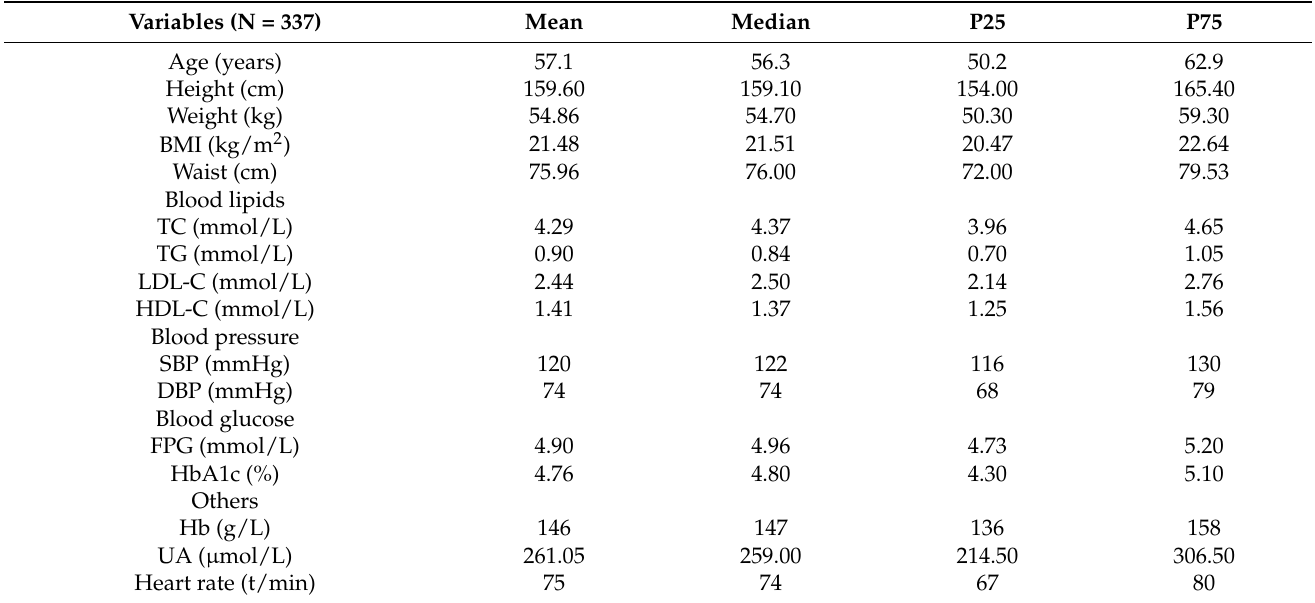
Table 1. Basic characteristics of the 337 healthy